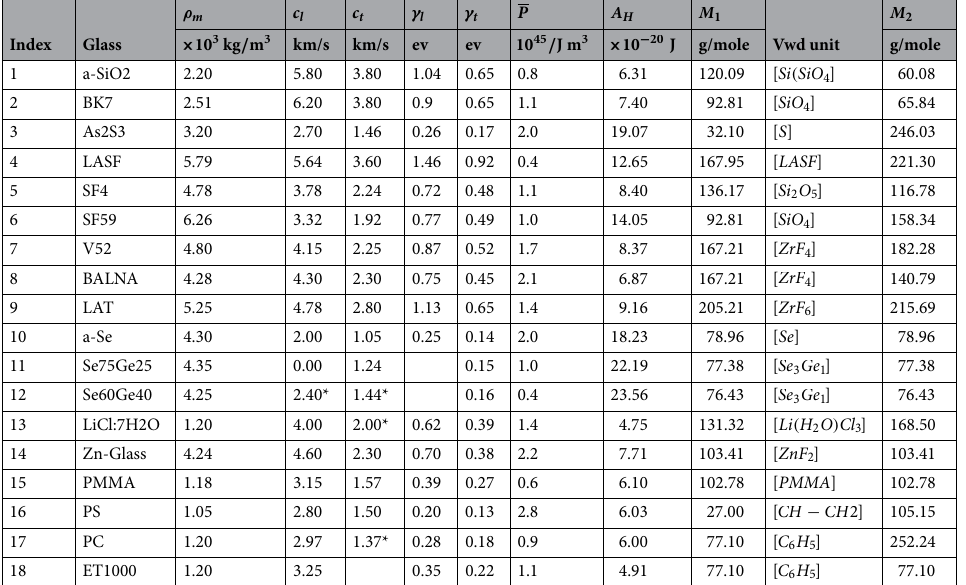
Table 2. (iii) A H : for materials in which spectral optical properties are not available, two refractive-index based approximation for A H namely, standard Tabor–Winterton approximation (TWA) (appropriate for low refractive index materials, n < 1.8 ) and single oscillator approximation (SOA) (for higher indexes n > 1.8 ), provide useful estimates 38 . The A H for 18 glasses listed in Table 2 are based on these approxi- mations (with details given in Ref. 28 ).